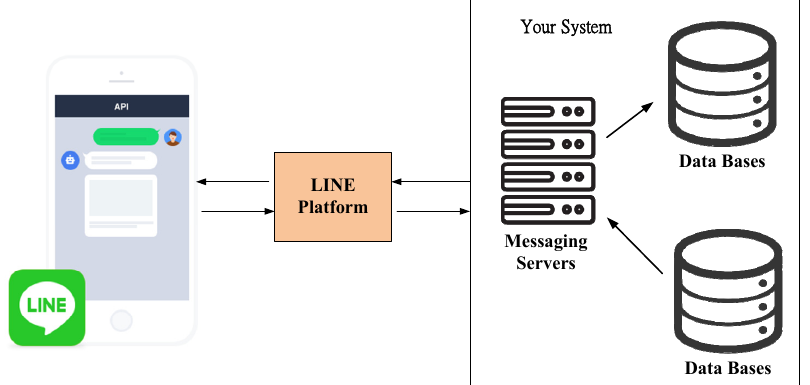
Figure 15. Messaging API flowchart.